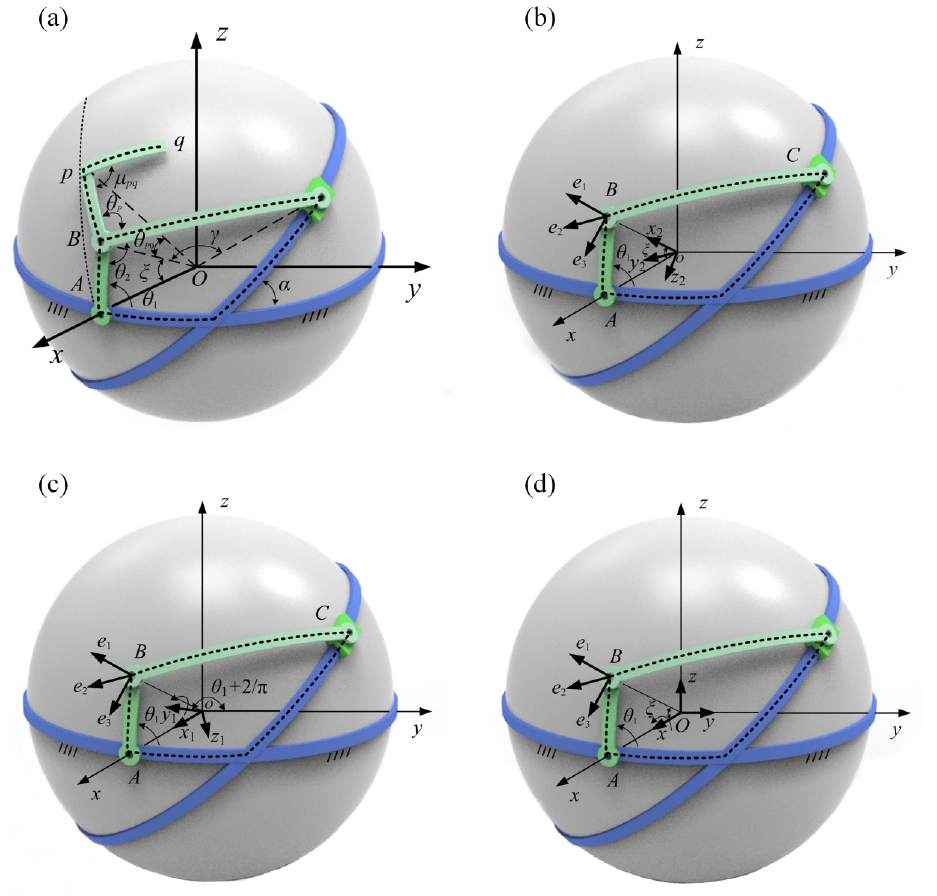
Figure 3. The transformation of the coordinate